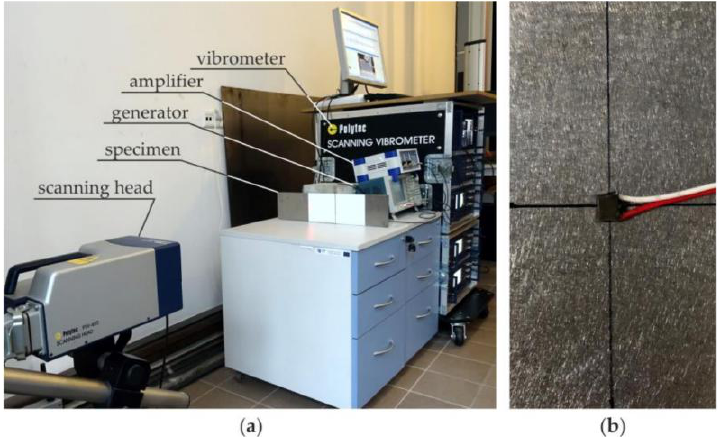
Figure 4. Experimental setup: ( a ) instrumentation for generation and acquisition of Lamb waves; and, ( b ) detail showing the piezo actuator attached to the specimen.